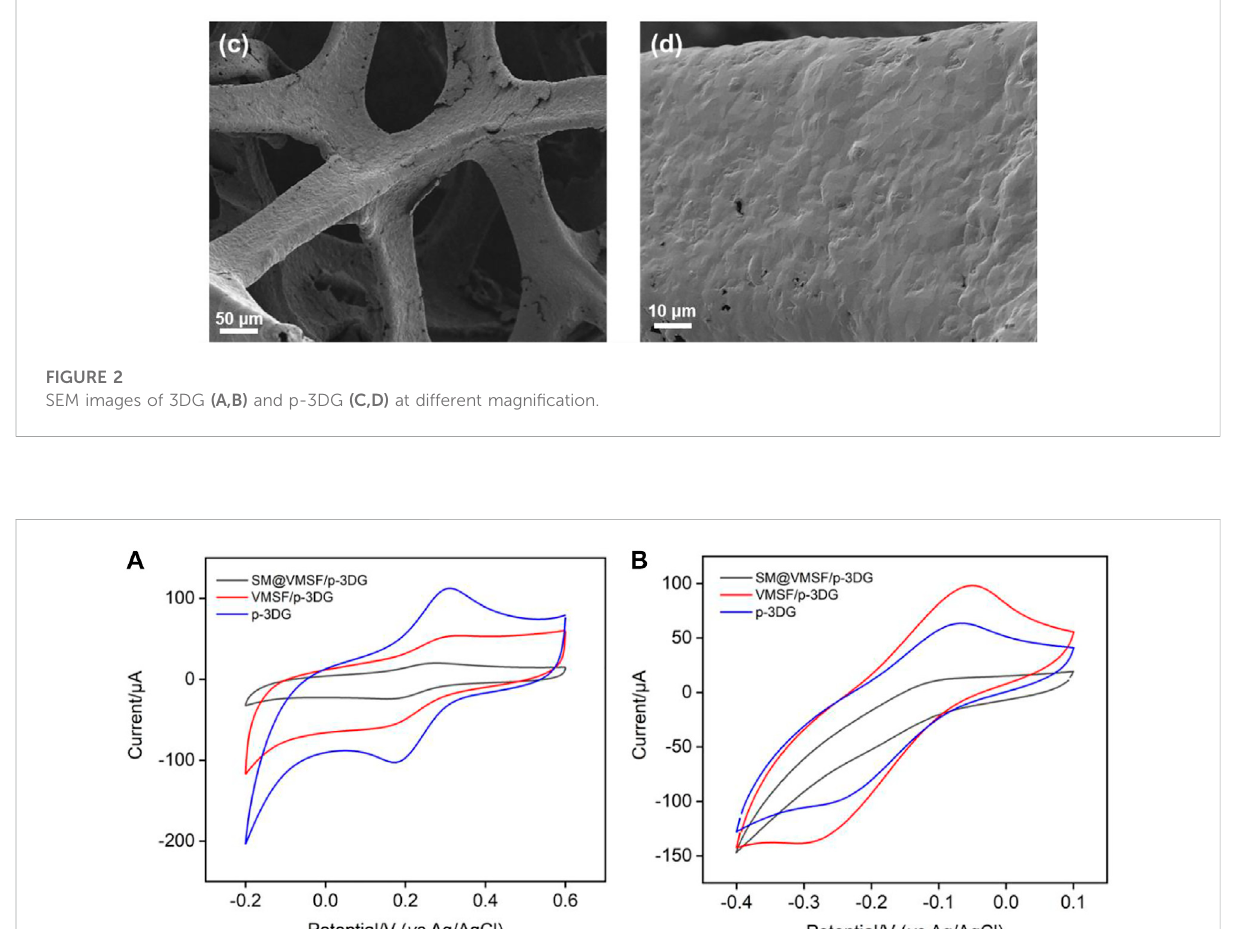
electrochemical peak current. The signi fi cant increase in the charging current also demonstrates the increase in the active area of the electrode. In addition, VMSF/p-3DG electrode exhibits the highest oxidation peak current, indicating the